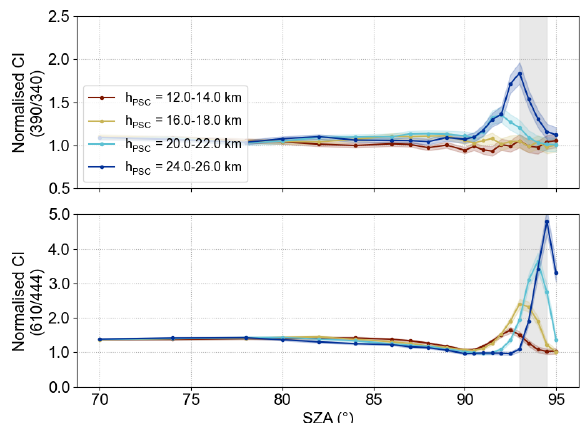
Figure B1. Simulation result (normalised CI) for different PSC layer heights h PSC ( τ PSC = 0 . 05). The PSC is confined in a 2 ◦ × 2 ◦ area.